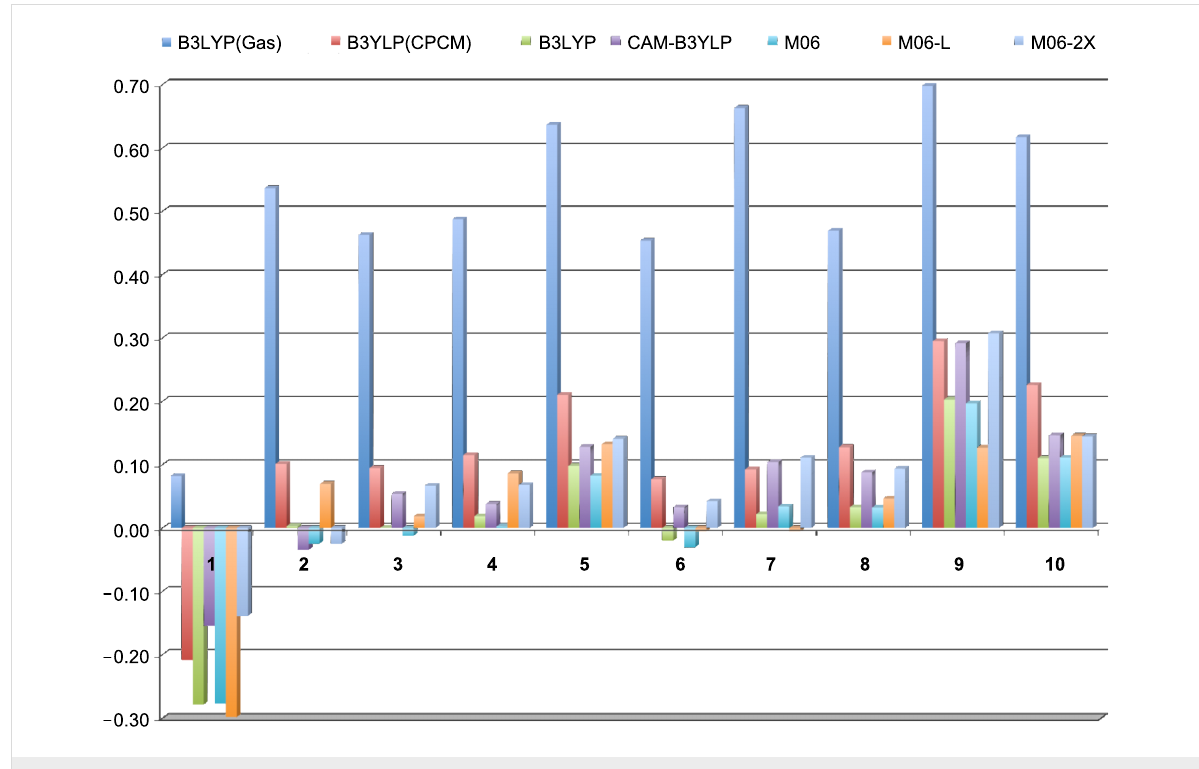
Figure 4: Error between experimental and calculated λ max values for each dye at the different levels of theory investigated. All errors are reported in eV. All structures were optimized in the gas-phase at the B3LYP/6-311++G(d,p) level of theory. B3LYP(Gas) refers to the TD-B3LYP calculation in the gas-phase. B3LYP(CPCM) refers to the TD-B3LYP calculation within the CPCM solvent model. All other TD-DFT calculations were carried out using the SMD solvent model as described in the computational